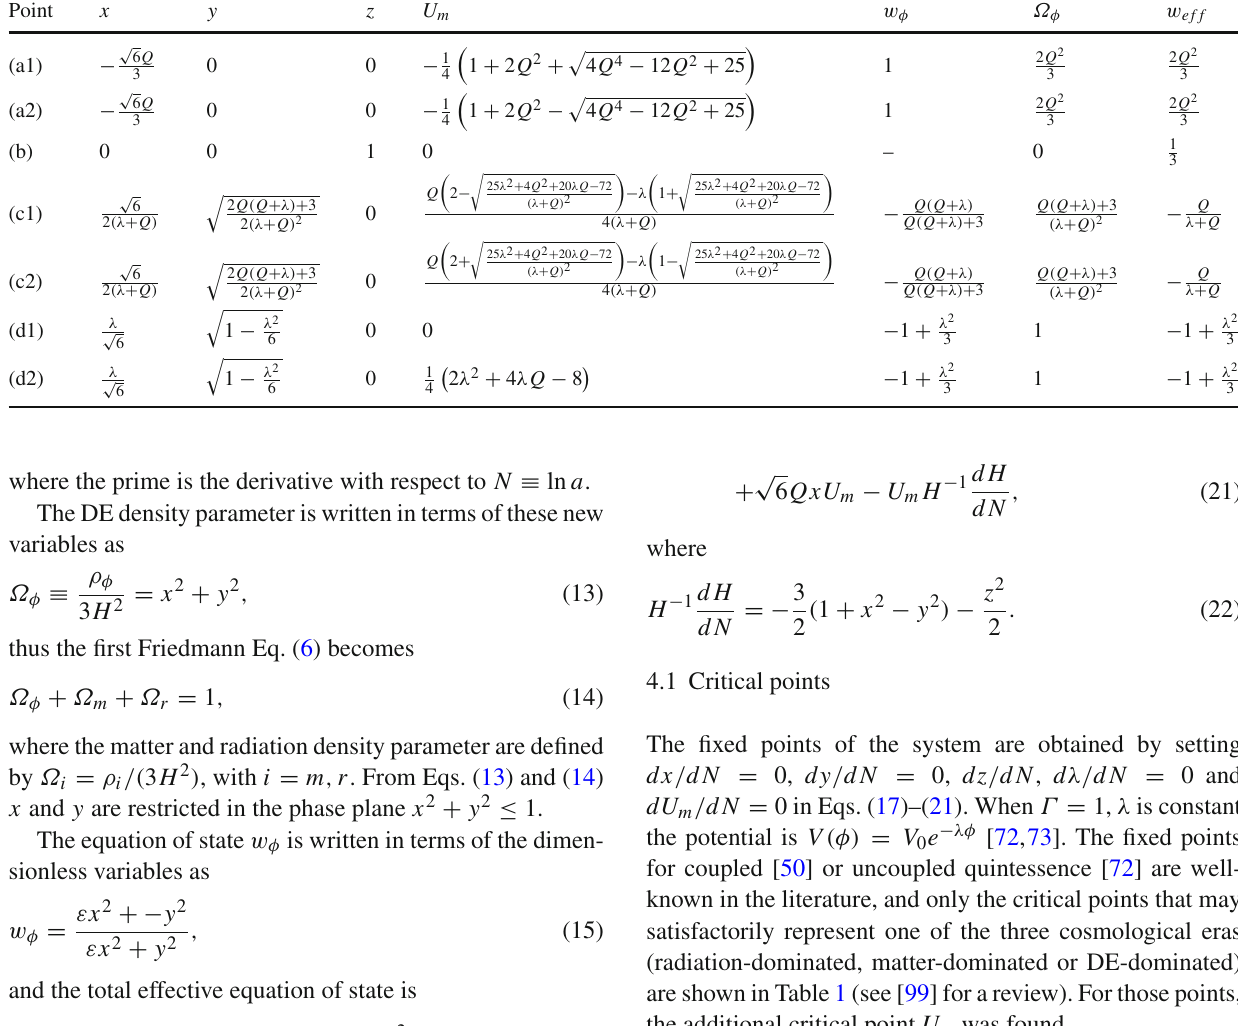
DE (15), the effective equation of state (16) and the density parameter for DE (13)